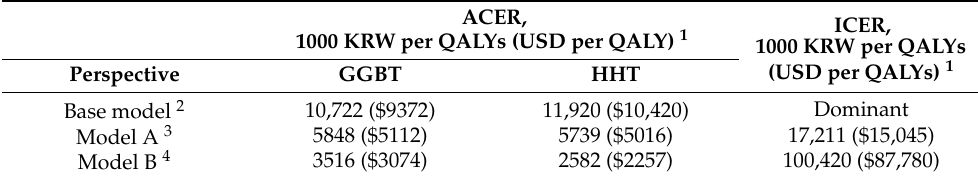
Table 4. The average and incremental cost-effectiveness ratios for GGBT compared to